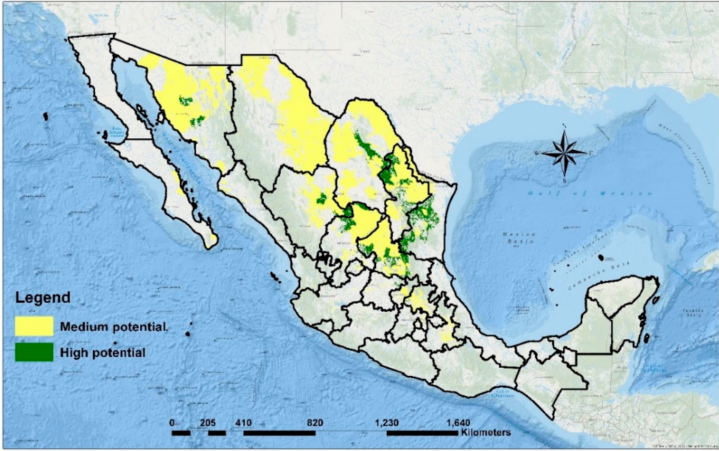
Figure 6. Agroecological spatial areas estimated for JCL cultivation in Mexico, scenario 2. High potential (green polygon) and medium potential (yellow polygon). Table 16. Summarized high and medium suitable land areas by federal state per findings in our study in contrast to findings of